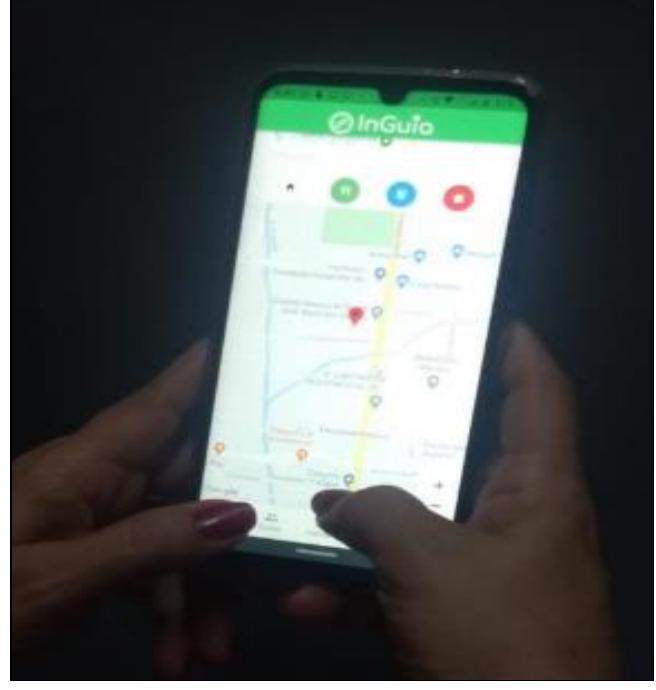
Figure 3: Usability test maps.